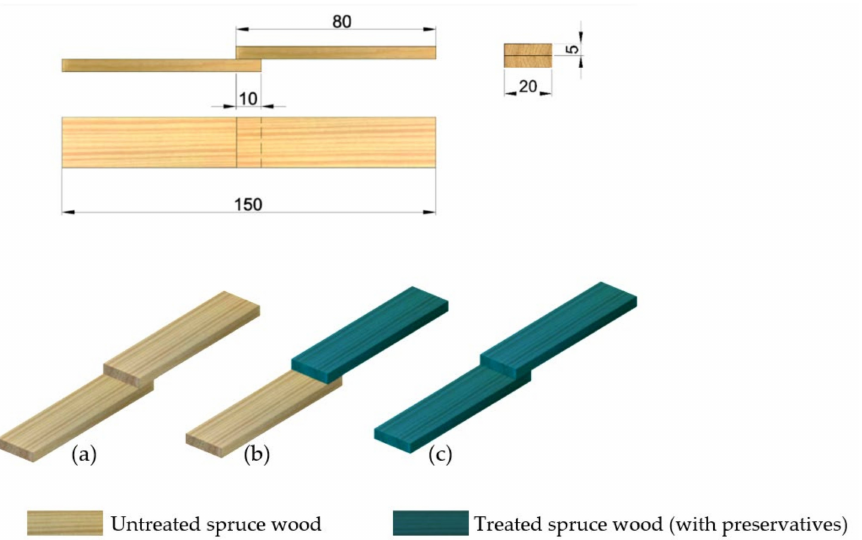
Figure 1. Dimensions of spruce wood specimens used for preparation of the control and test sets according to the standard EN 205 [49]. Dimensions are in mm. Composition of the sets is analogous with the sets prepared from themmally treated spruce woods [54]. Notes: ( a ) Control set, ( b ) First group of test set (Treated spruce and Untreated spruce), ( c ) Second group of test set (Treated spruce and Treated